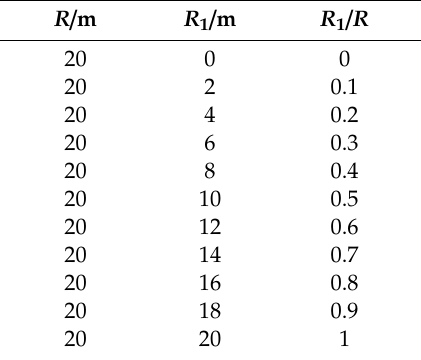
Figure 13. Model for numerical simulation with shock absorber. Table 3. Installation position of shock absorber.